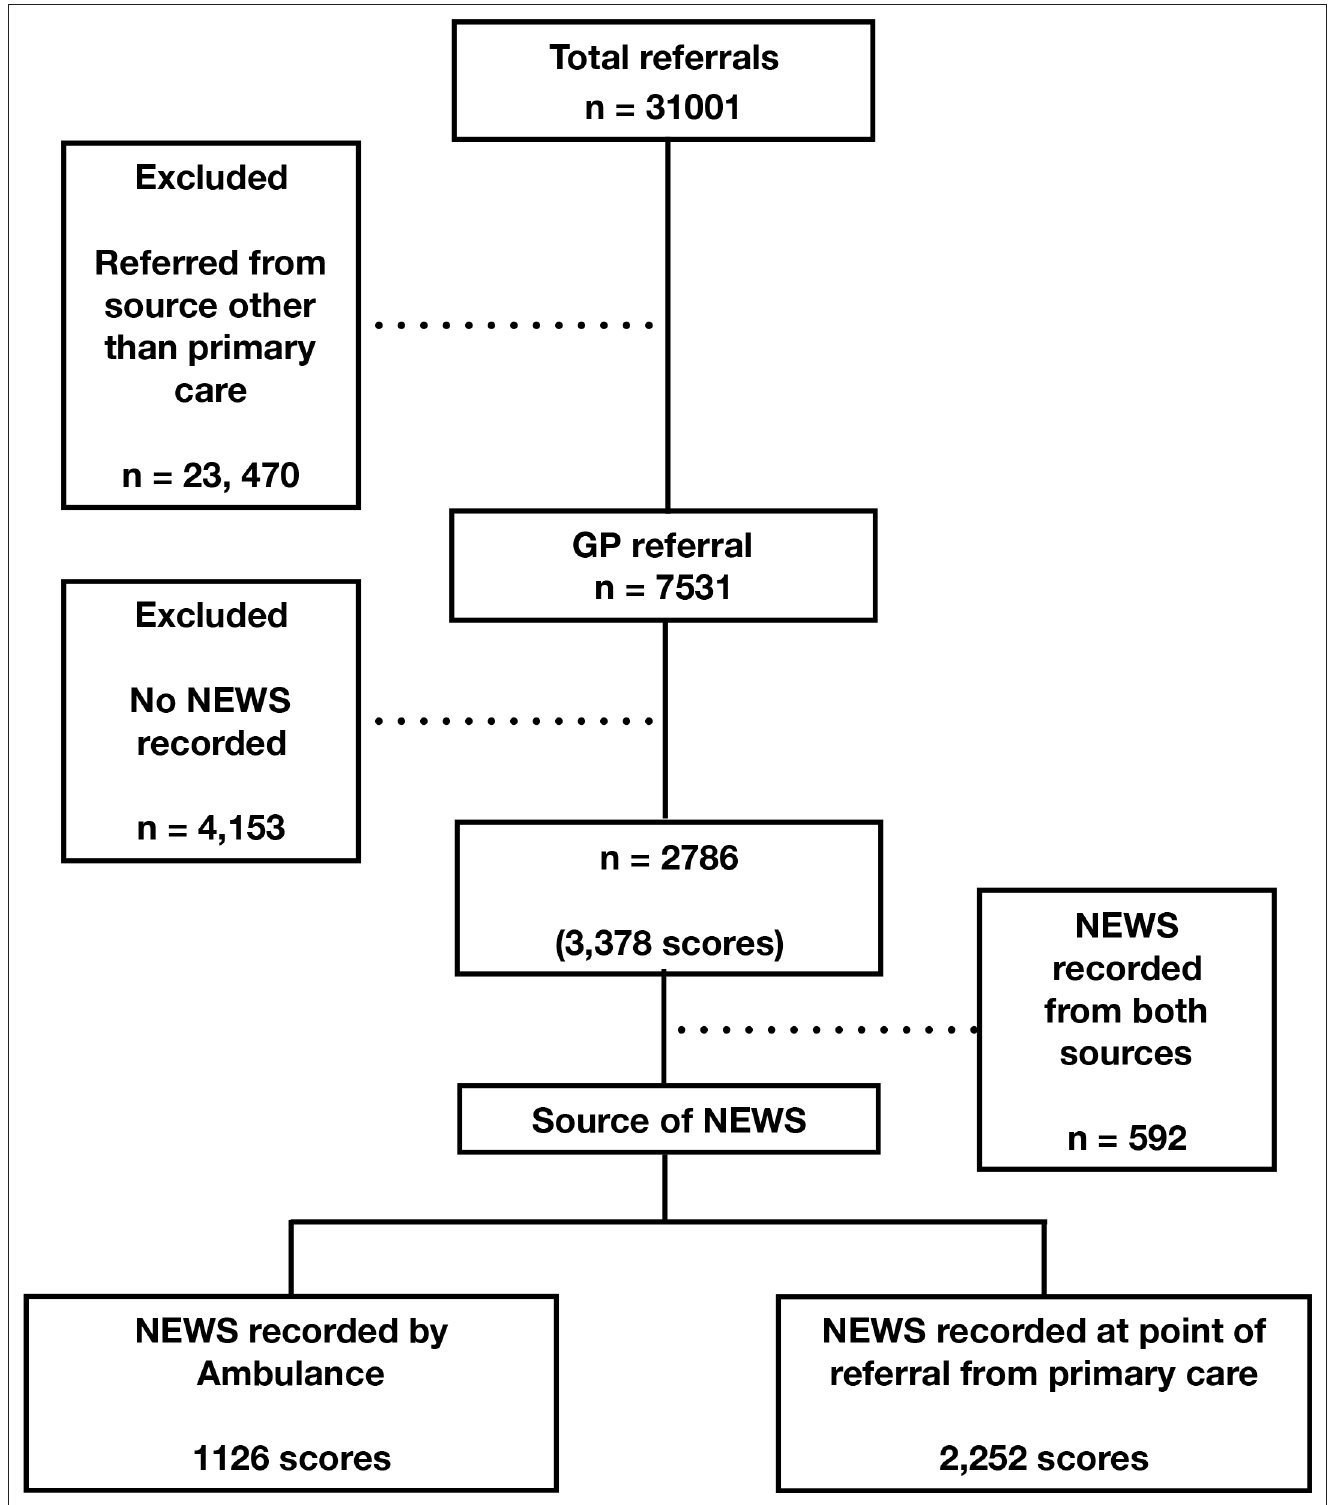
Figure 1 Flow diagram demonstrating study